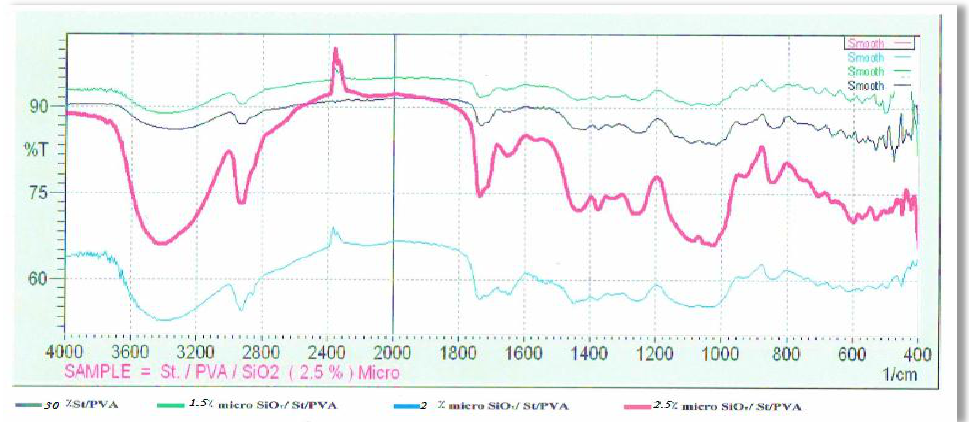
Fig. 10: FTIR spectra of nano SiO